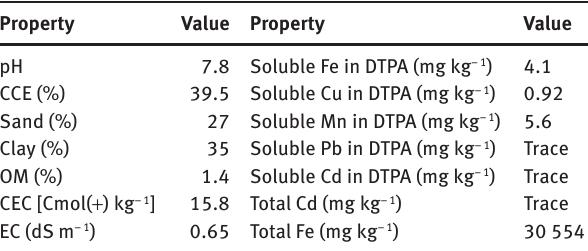
Table 1: Selected chemical and physical properties of soil used in the present